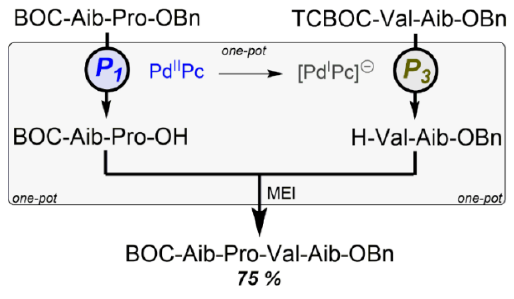
Scheme 4. Reaction control by catalyst Pd z Pc in the one-pot synthesis of the alamethicin [13–16] sequence.